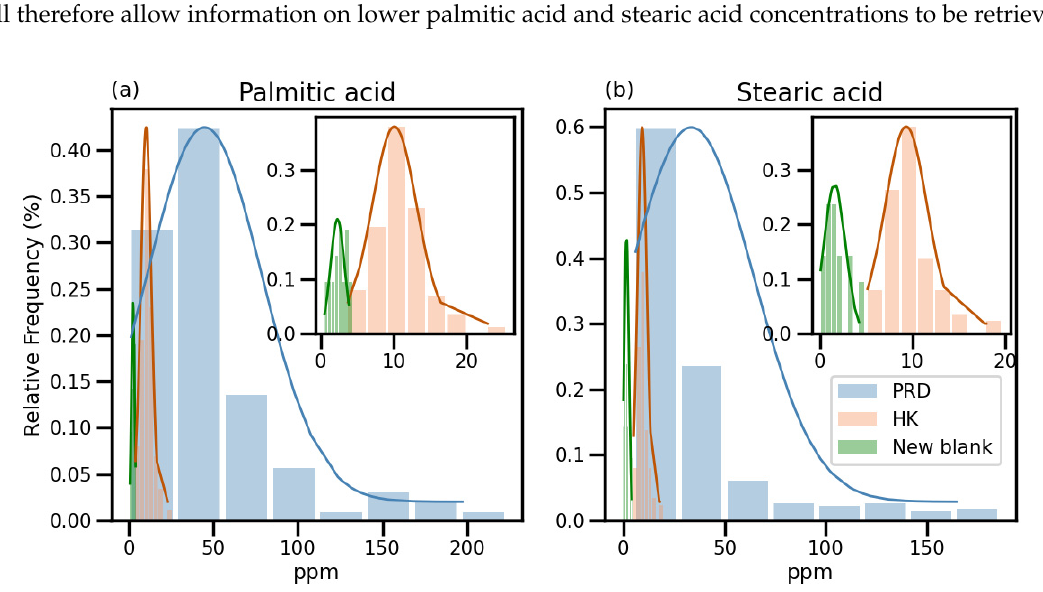
Figure 5. Contrast of concentrations of ( a ) palmitic acid and ( b ) stearic acid as measured by the revised new method and shown as relative frequency distribution histograms for method blanks ( n = 21, marked in green color) and the ambient samples. The ambient samples (the Pearl River Delta (PRD) samples in sky blue color and the HK samples in cantaloupe brown color) are the same as those displayed in Figure 3. Insert plots are zoomed-in images of the histograms of field blanks and the HK samples. The solid lines denote the normal distributions of the corresponding data.